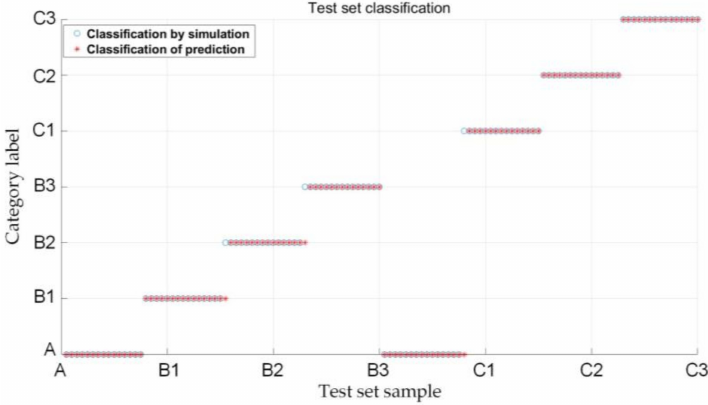
Figure 27. Classification results.